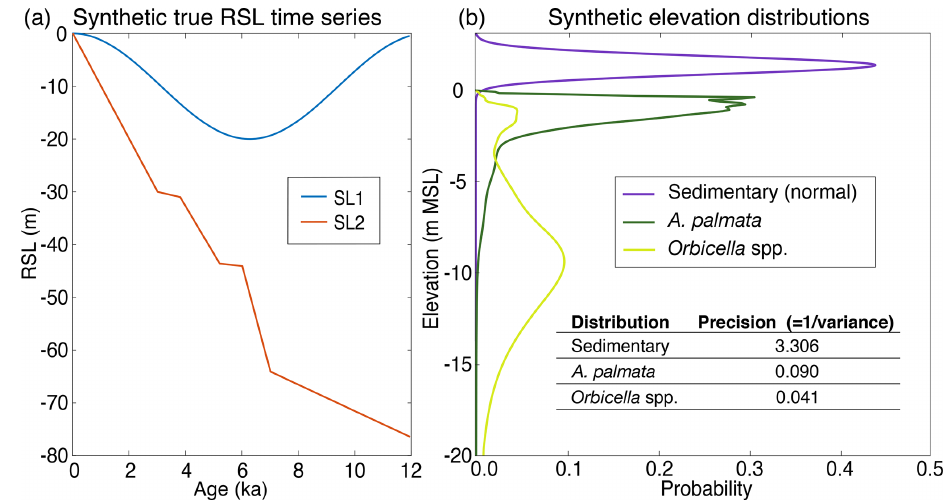
Figure 4. (a) Synthetic relative sea-level (RSL) time series, which simulate rates characteristic of the Holocene (SL1) and the last deglaciation (SL2); (b) precision and elevation of the synthetic data distributions, where sedimentary indicators are normally distributed and centered above mean sea level (MSL), while Acropora palmata ( A. palmata ) and Orbicella spp. are distributed according to their regional empirical distributions below